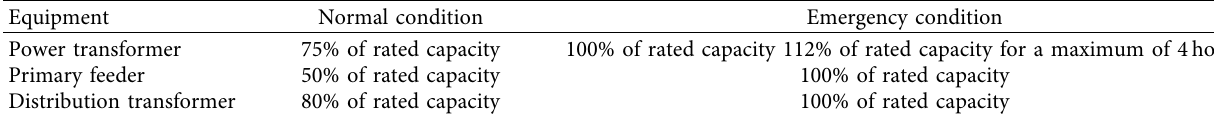
Table 4: Planning criteria for load-carrying capability.